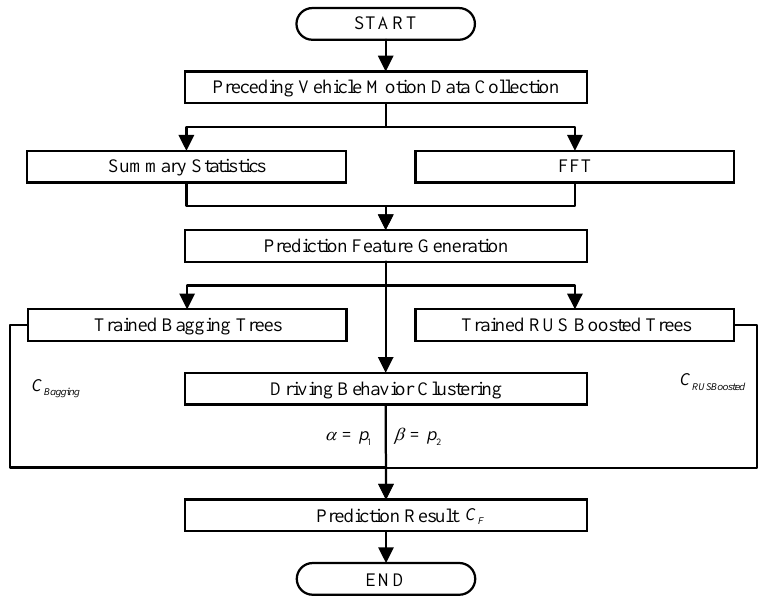
Figure 7. Two-stage method flow chart.